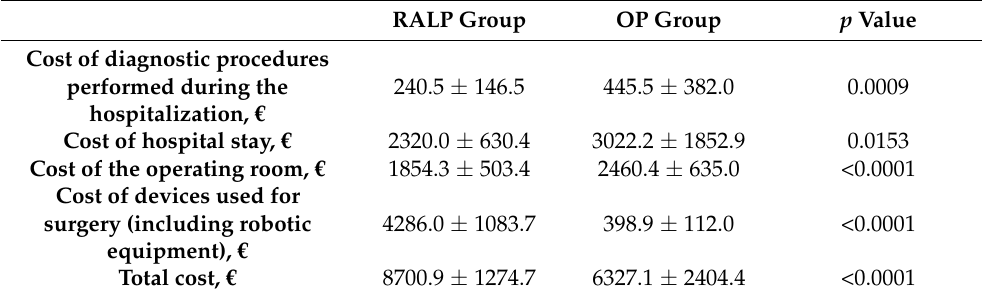
Table 3. Cost data. Values are means ± standard deviation.